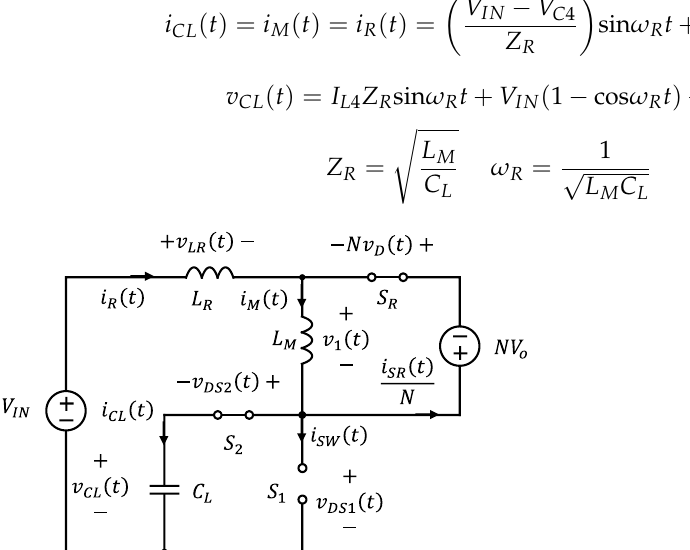
Figure 9. Equivalent circuit in state 4.